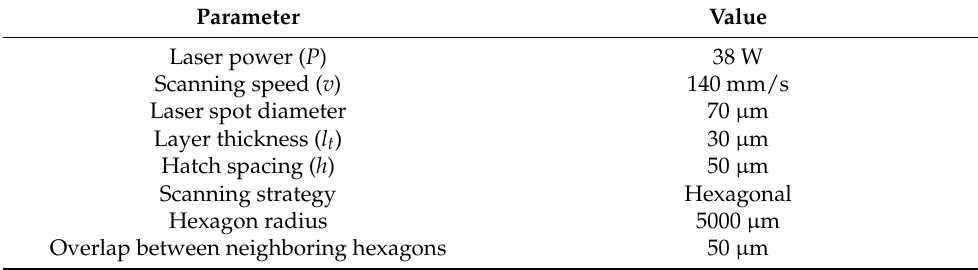
Table 2. Invariant process parameters of the SLM